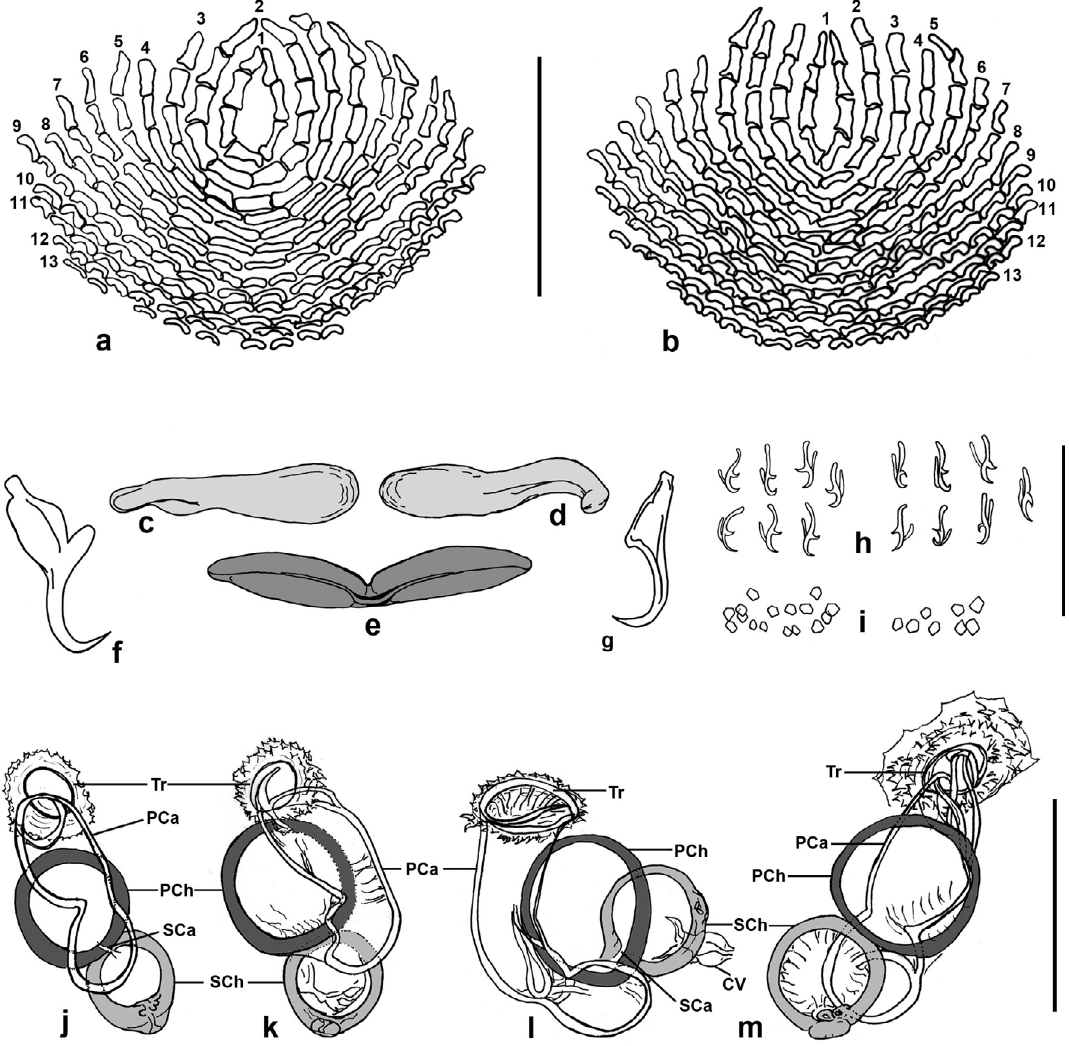
Figure 2. Pseudorhabdosynochus jeanloui n. sp. from Paranthias colonus . a, b , squamodiscs; a , ventral, and b , dorsal, from holotype, Hoyer. c, d , dorsal bars, holotype, Hoyer, ventral view. e , ventral bar, holotype, Hoyer, ventral view. f–g , hamuli; f , ventral hamulus, and g , dorsal hamulus, paratype, Hoyer, ventral view. h , hooklets from various specimens, ventral view. i , tegumental scales, holotype, Hoyer. j–m , sclerotized vaginae of various specimens; Tr, trumpet; PCa, primary canal; PCh, primary chamber; SCa, secondary canal; SCh, secondary chamber; CV, unsclerotized canal from secondary chamber to ootype. j, paratype, carmine; k–m, paratypes, Hoyer; j–l, dorsal view; m, ventral view. Scale bars: 40 l